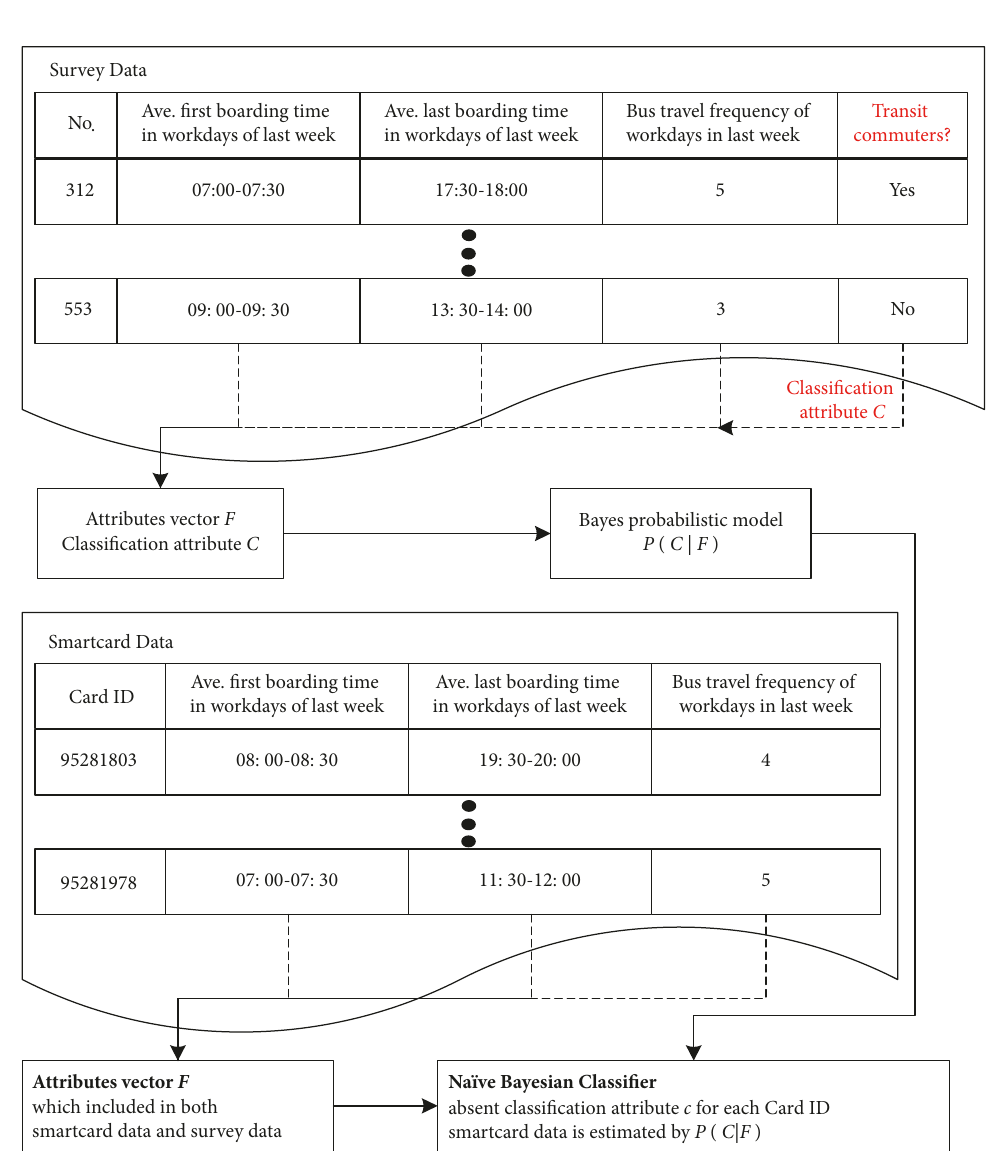
Figure 3: Flow chart of NBC for identifying commuters in smartcard